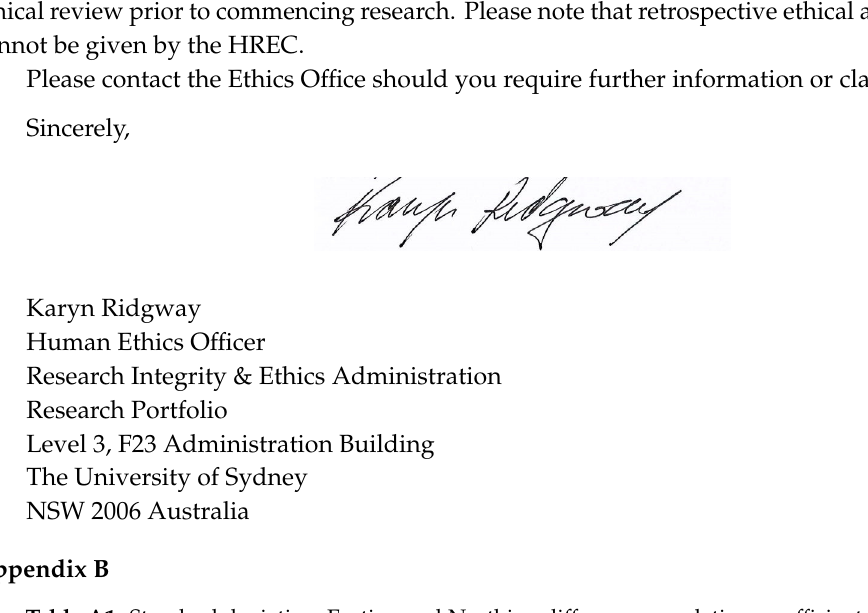
Table A1. Standard deviation, Easting and Northing di ff erence correlation co-e ffi cient for comparisons Table B1. Standard deviation, Easting and Northing difference correlation co-efficient for ( n = 10) of accuracy of RRApp taken by SMGPS app and the comparisons ( n = 10) of accuracy of RRApp taken by SMGPS app and the RRApp.